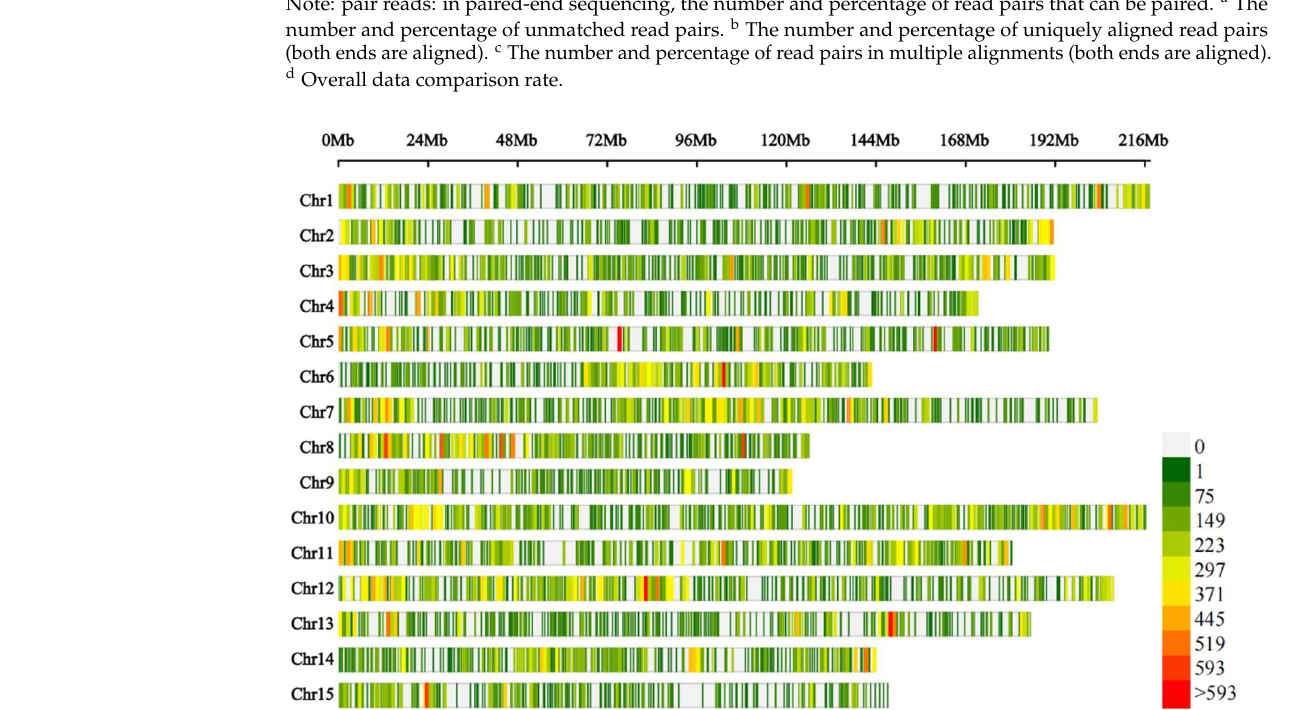
Table 2. Alignment results of two bulks Reads on whole genome sequences of C. oleifera var.